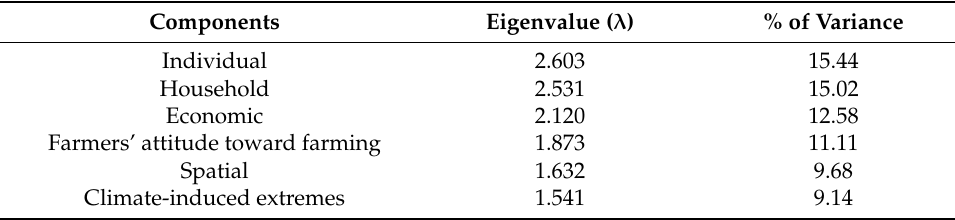
Table 4. Eigenvalue and percent contribution of factors to the total variance ( n =